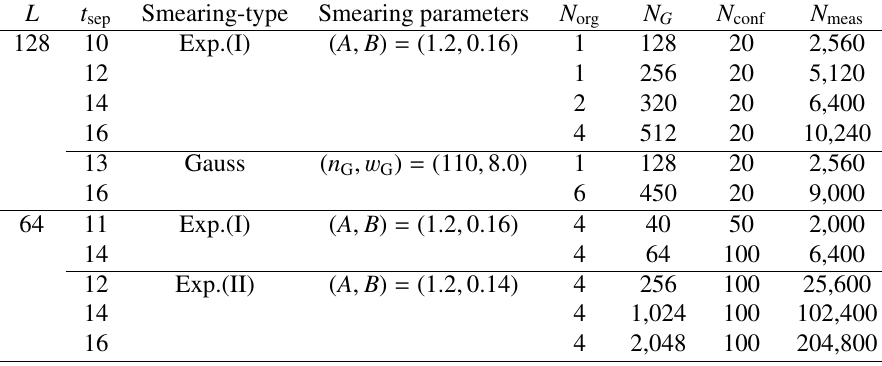
Table 1: Details of the numerical mesurements: lattice size ( L ), time separation ( t sep ), smearing-type and -parameters of the quark operator, the number of measurements for the high- and low-precision computations ( N org and N G ), the number of gauge configurations ( N conf ) and the total number of measurements ( N meas = N G × N conf ), respectively. L t